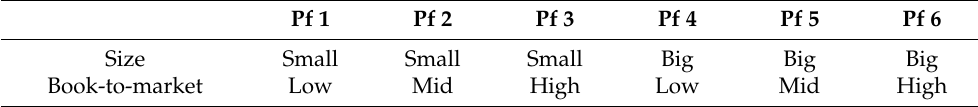
Table 3. Combination portfolios based on size and book-to-market values. Pf 1 Pf 2 Pf 3 Pf 4 Size Small Small Small Big Big